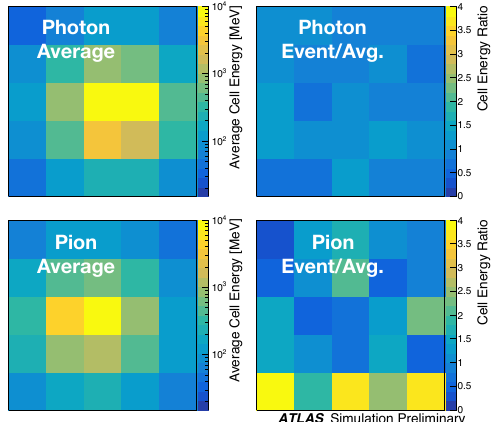
Figure 2. Example of photon and pion average shapes in 5 × 5 calorimeter cells. The left column shows the average shape over a sample of 10000 events, while the right column shows the energy ratio, in each cell, of single Geant4 events with respect to this average. The photon ratios are all close to 1, while the pion ratios show significant deviation from the average